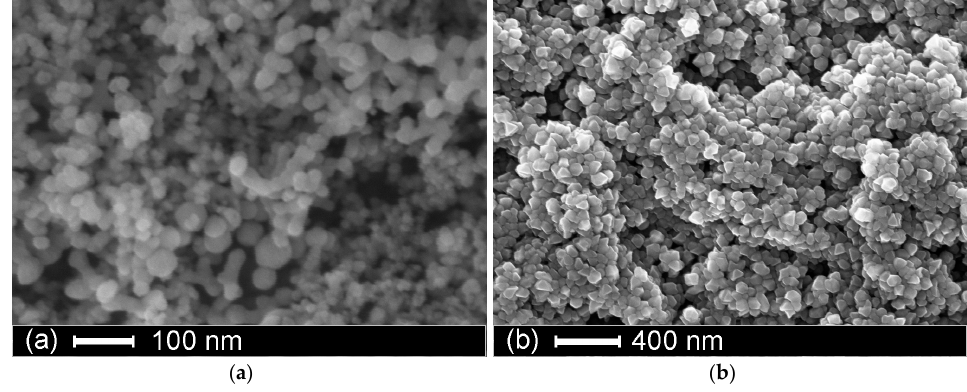
Figure 2. Scanning electron microscope (SEM) investigation of different structure layers. ( a ) nc-Si film without the top Al electrode, ( b ) the surface of the top Al electrode. Images represent the top view of the structures.